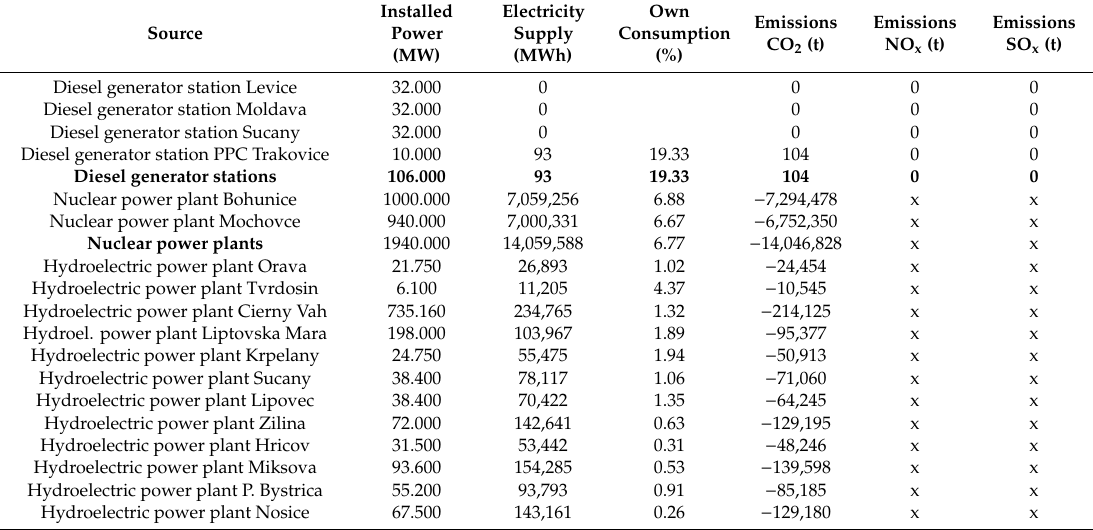
Table A1. List of selected sources of electricity production within the Slovak electrical system. (Source: